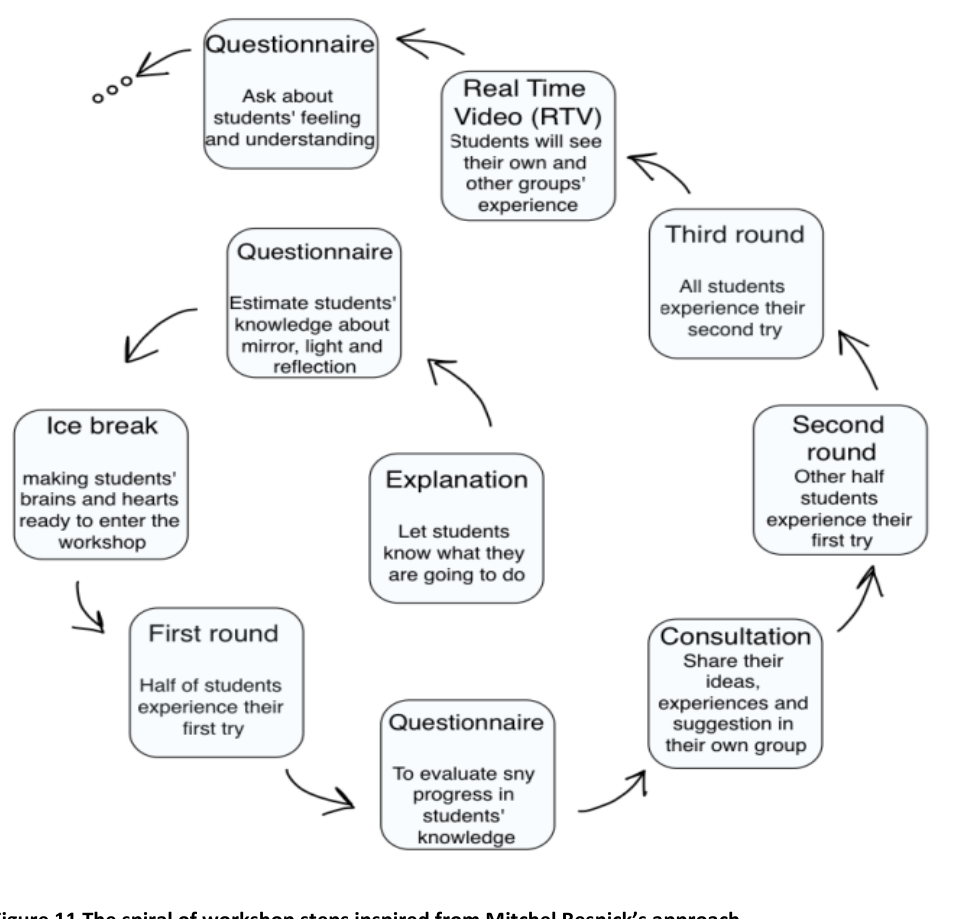
Figure 11 The spiral of workshop steps inspired from Mitchel Resnick’s